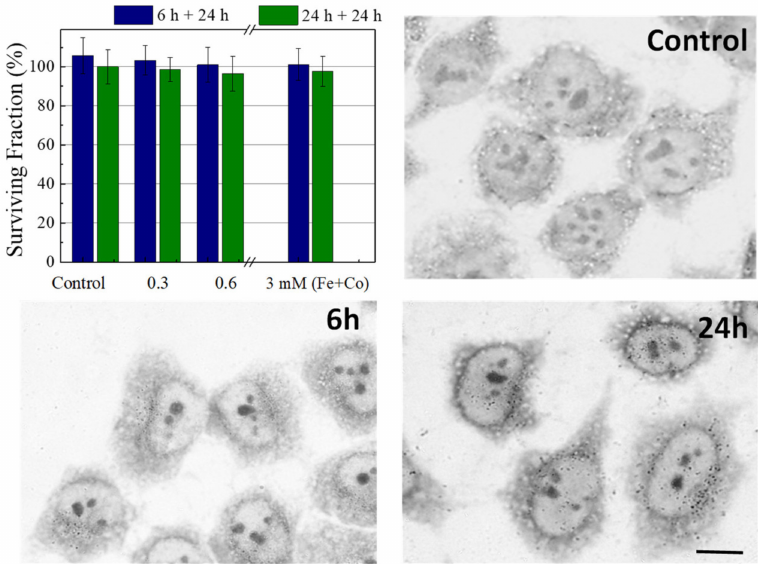
Figure 5. Bars diagram of biocompatibility of NPs functionalized with folic acid in HeLa cells measured by MTT assay. Blue columns, cells incubated 6 h with different concentrations of NPs and their viability measured 24 h later. Green columns, cells incubated for 24 h and their viability measured 24 h later. The results represent the average of 6 independent experiments. Optical micrographies of control cells, NP-FA 0.6 mM internalization in HeLa cells incubated for 6 and 24 h. Scale bar 10 µ